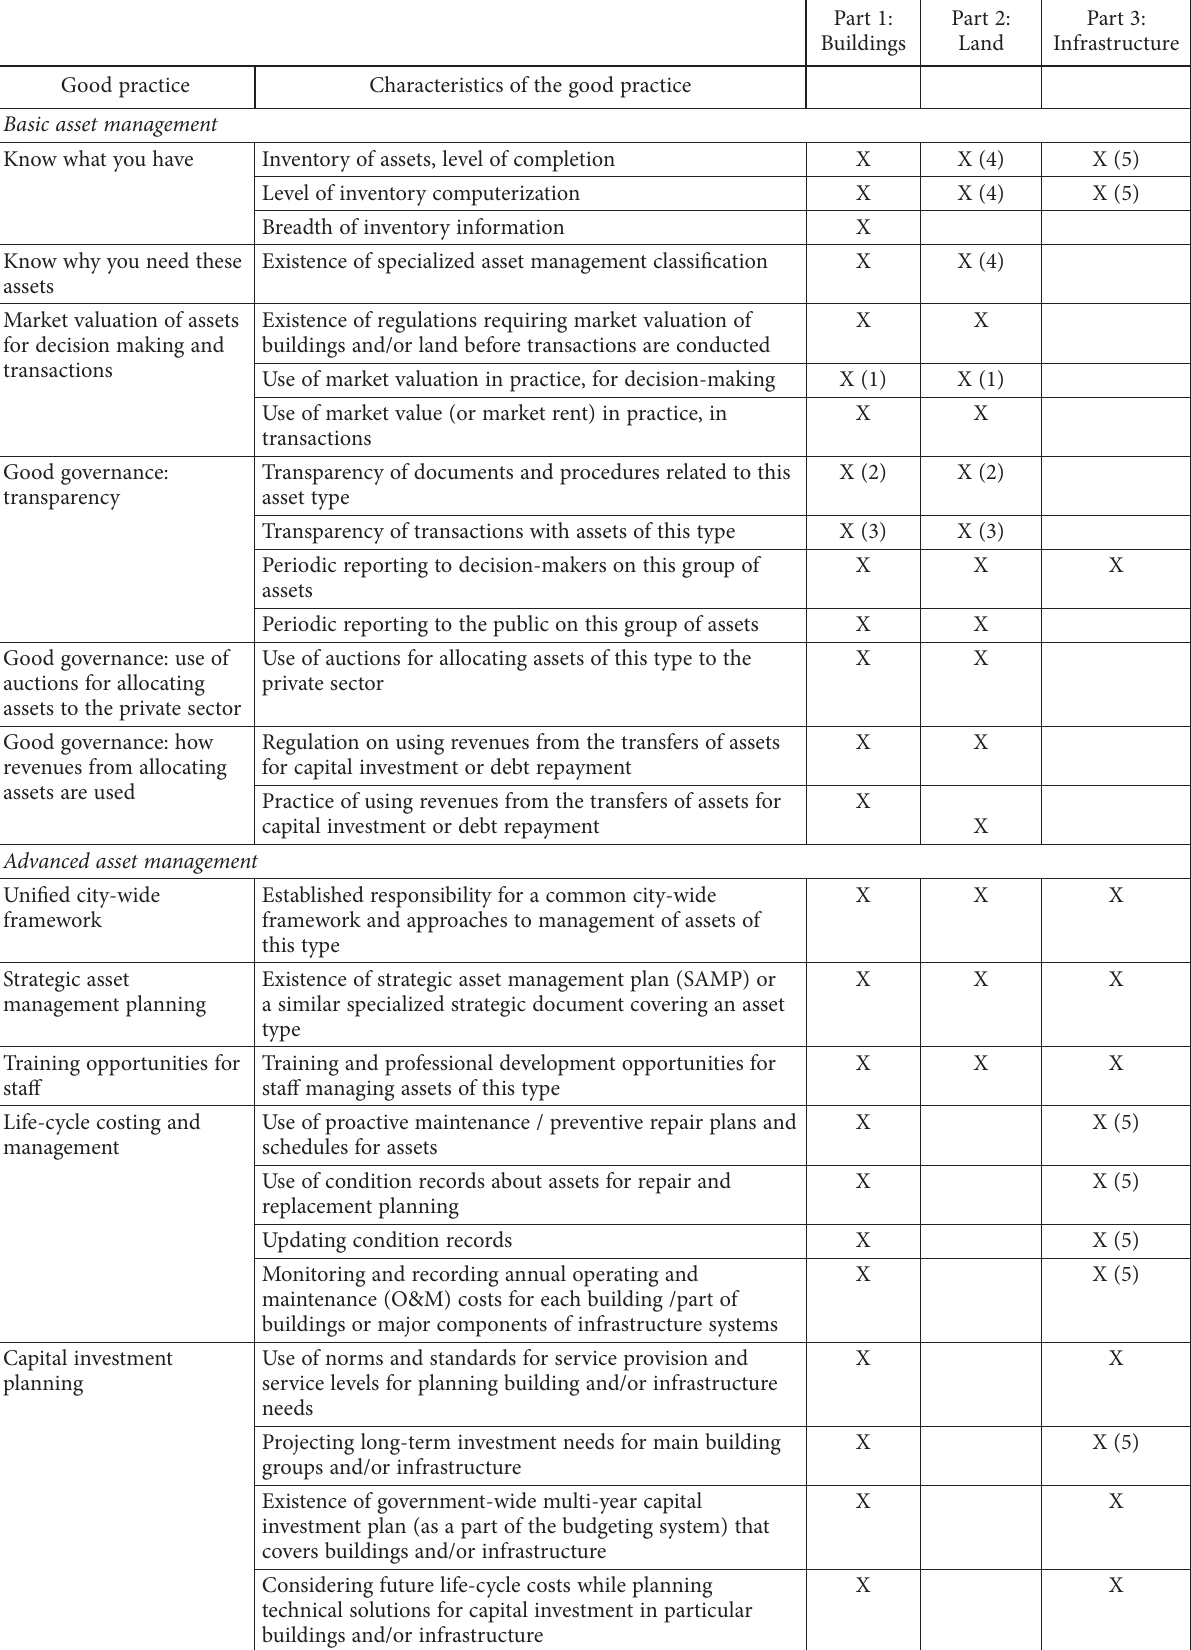
Table 1. Good practices and their characteristics